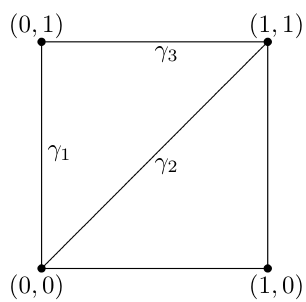
Figure 8 . Triangulation of the once-punctured torus C for τ elements γ i of the Seiberg-Witten curve Σ u ; m .